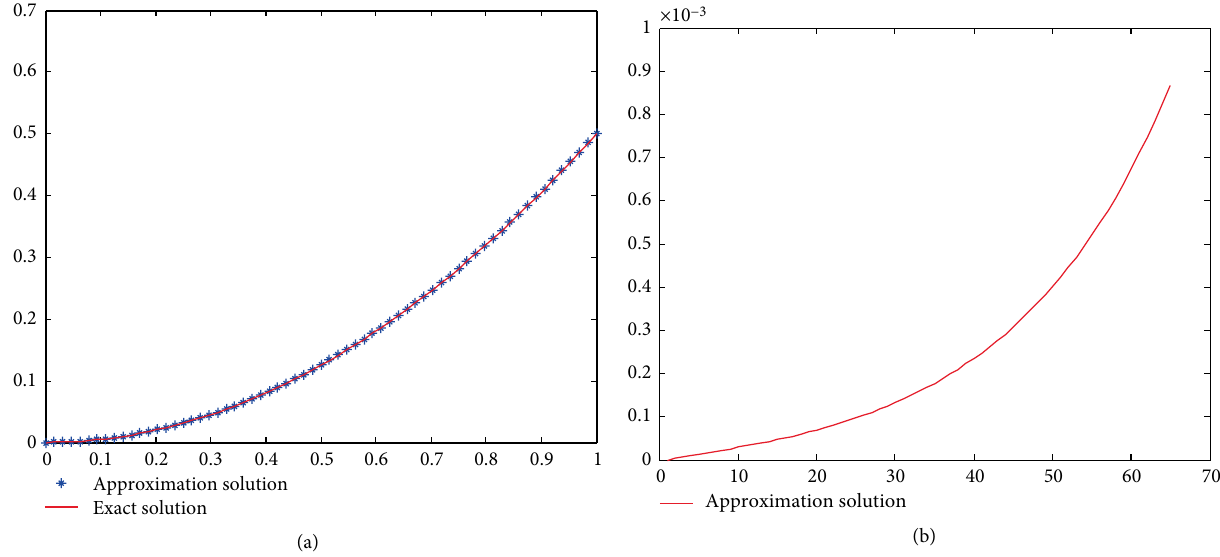
Figure 4: A comparison and absolute error between exact and numerical solutions in Example 2 with 𝑁 = 64 . (a) A comparison. (b) Absolute